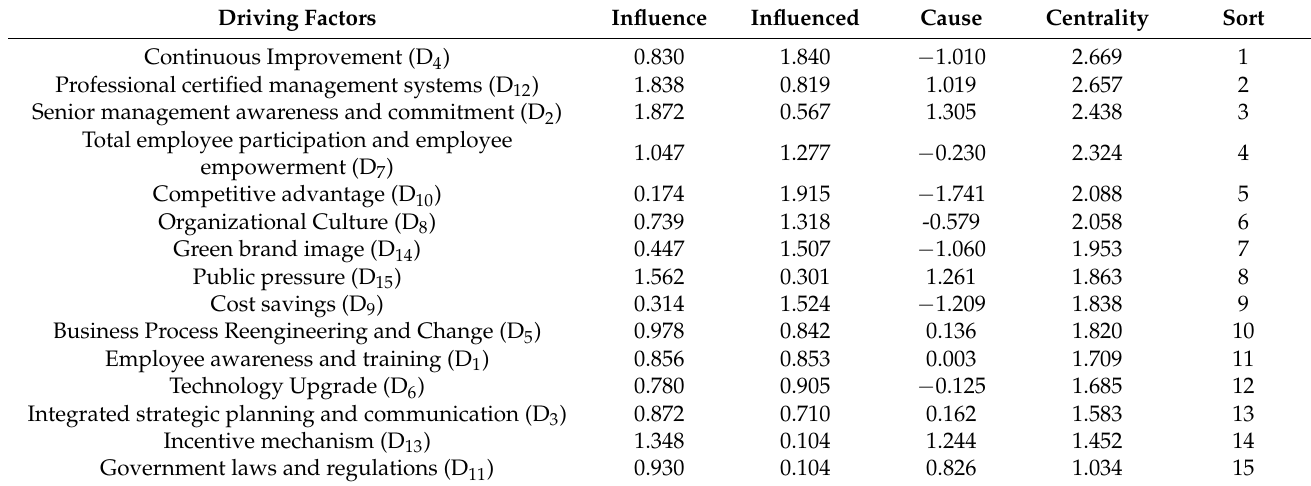
Figure 3. Centrality distribution of driving factors.